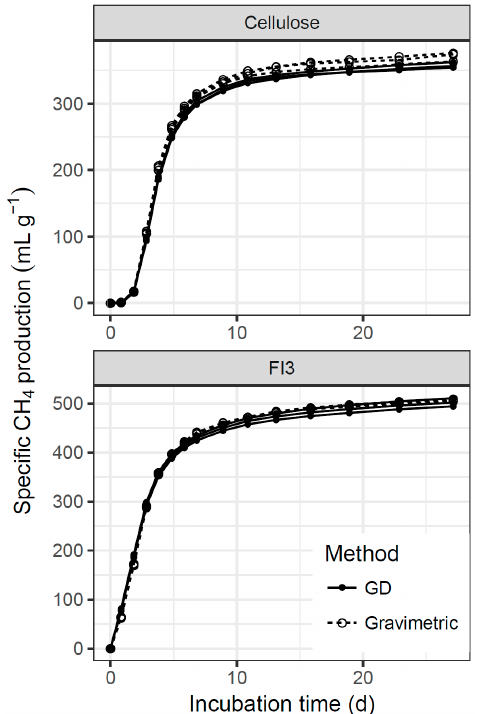
Figure 5. Specific methane production (SMP) curves from Experiment 2 for microcrystalline cellulose and FI3 from the gravimetric (dashed lines) and gas density (GD t , solid lines) methods. Because GD and GC measurements of 𝑥 (cid:2887)(cid:2892) were not made for the same bottles in Experiment (cid:3120) 2, values were not compared. Instead, CH 4 production (normalized by inoculum mass) was compared among inoculum-only bottles in order to clarify the limits of the GD method. On average,